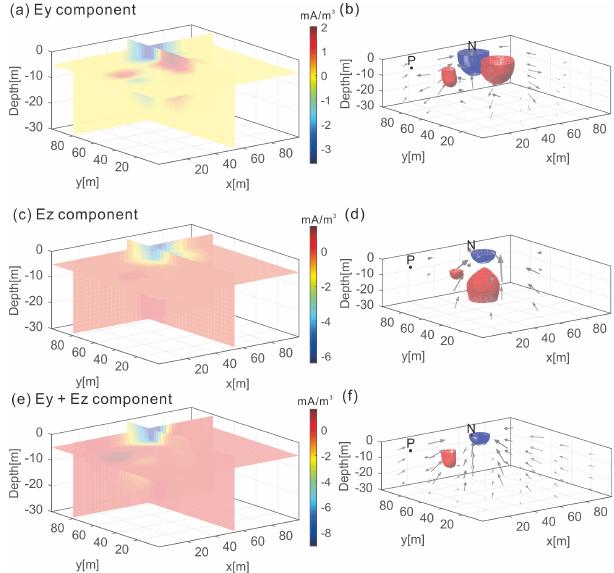
Figure 7. Volumetric current density inversion results of differ- ent components of observed data, with p = 1 and α = 0 . 01. Panels (a) and (b) show the inversion results of volumetric current den- sity of horizontal components of electrical field data (magnitude and direction). Panels (c) and (d) show the inversion results of the charge density of the vertical component of observed data (magni- tude and direction). Panels (e) and (f) the inversion results of the charge density of both components of the observed data (magnitude and direction). The arrow direction indicates the diffusion direction of the current density. The intersection of the vertical section is the position of the negative pole of the artificial source. Although the anomaly recovery for a single component can also localize the neg- ative pole, the two-component inversion returns a single compact current density. The notation P corresponds to the location of the positive pole of the artificial source. The notation N corresponds to the location of the negative